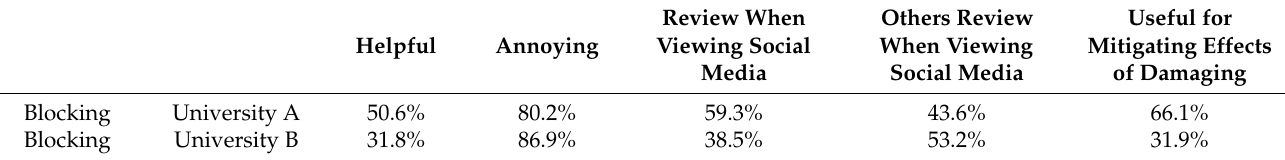
Table 14. Blocking survey results by category and by